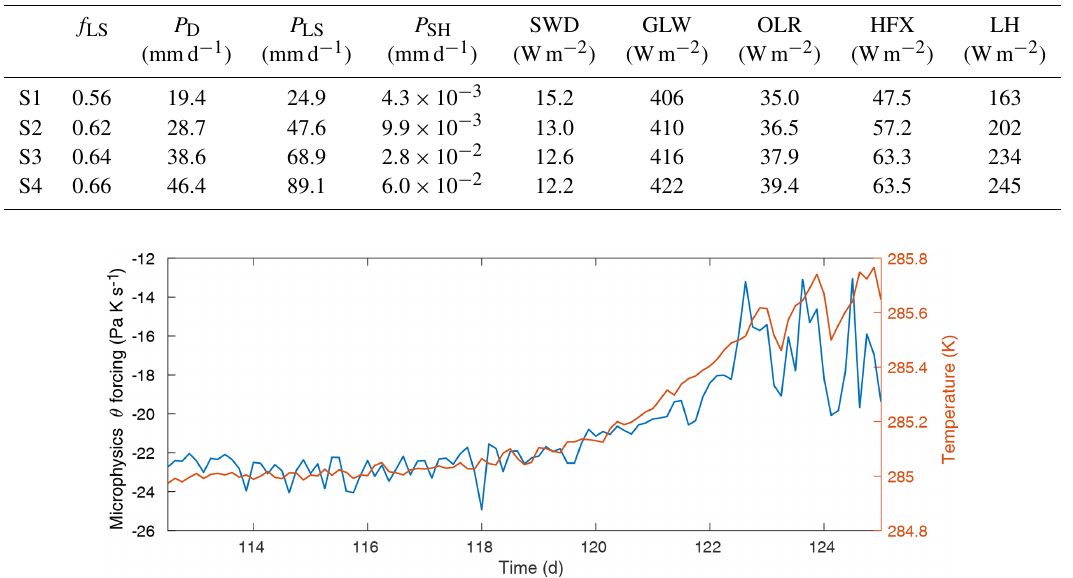
Figure 6. Left axis: the microphysics θ forcing at roughly 835mb (blue) during the first abrupt transition. Right axis: the temperature at the same level